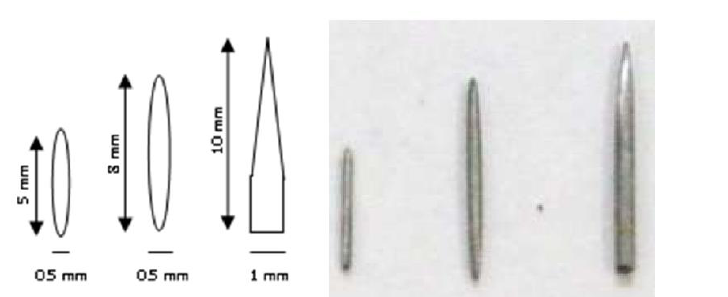
Figure 3. Electrodes system.